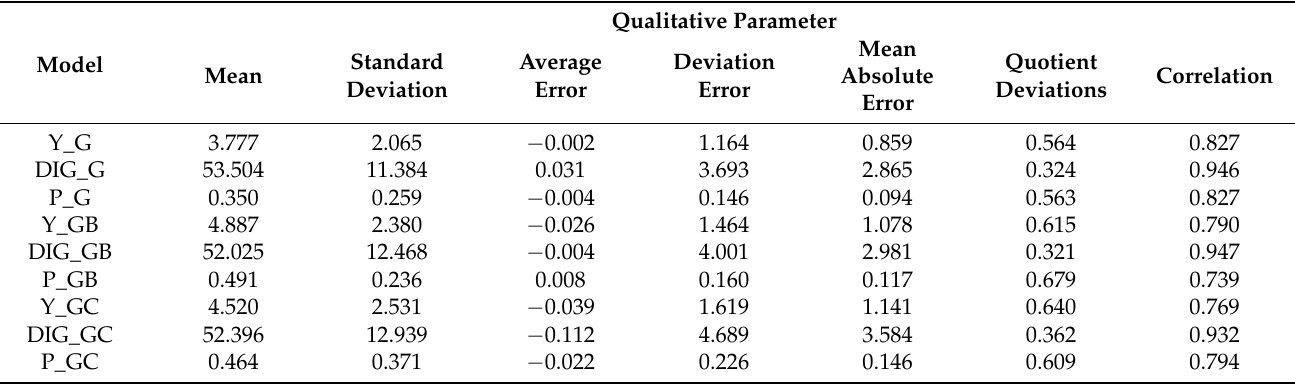
Table 5. The values of the main qualitative parameters for the neural networks in the tested models. Qualitative Parameter Model